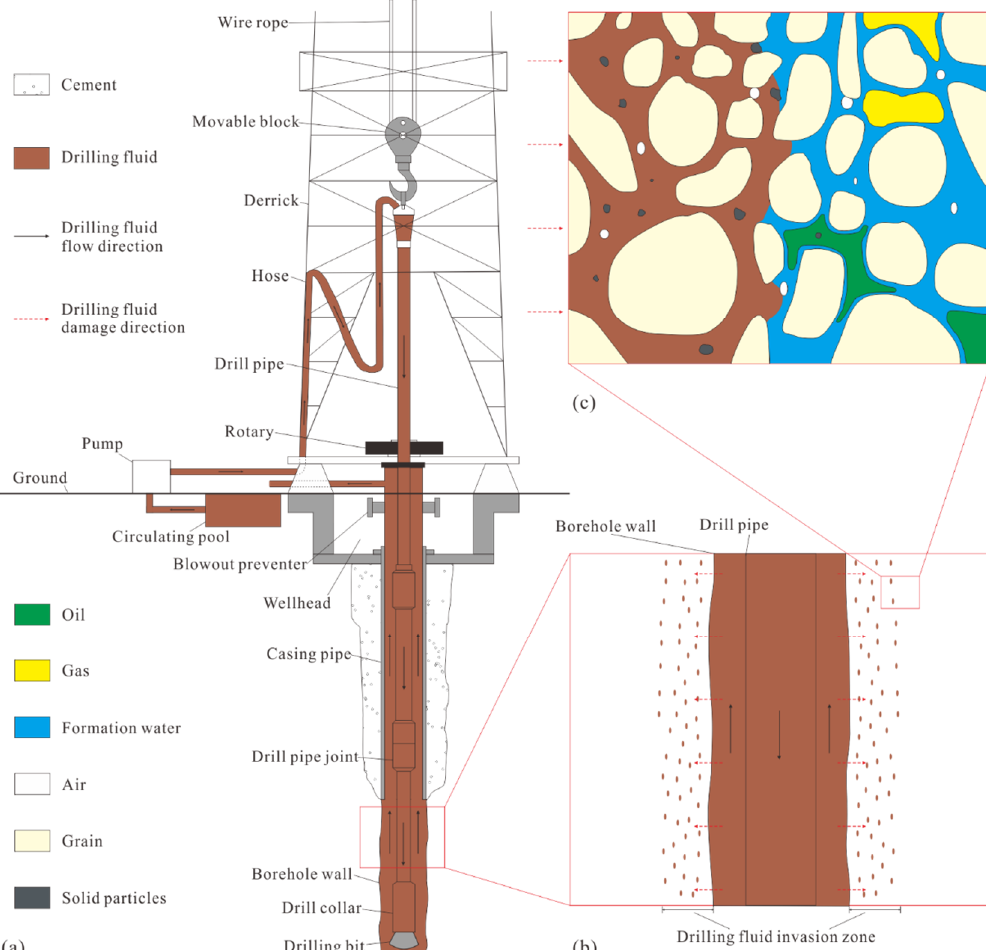
Figure 1. Schematic diagram of drilling fluid cycle and formation damage: ( a ) diagram of drilling fluid cycle during well drilling; ( b ) diagram of drilling fluid invading formation and causing formation damage; ( c ) diagram of microscopic formation damage.